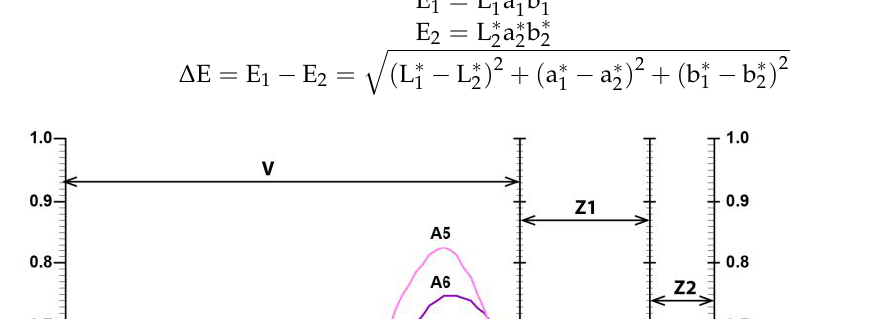
Figure 12. Comparison of the spectrographs for the Green and Dark Red process twin dyes. To obtain the appropriate quality of dye twins and colors for VZ reproduction, we performed an analysis of 12 twins (Table 1) to derive parameters for the relationship using the regression method [1]. The interdependence of the dye formulations between the visible and NIR spectra was determined. The painter determines the dye mixtures by observing and photographing them with dual ZRGB cameras in the VIS and NIR spectra [1]. From these photographs, the painter